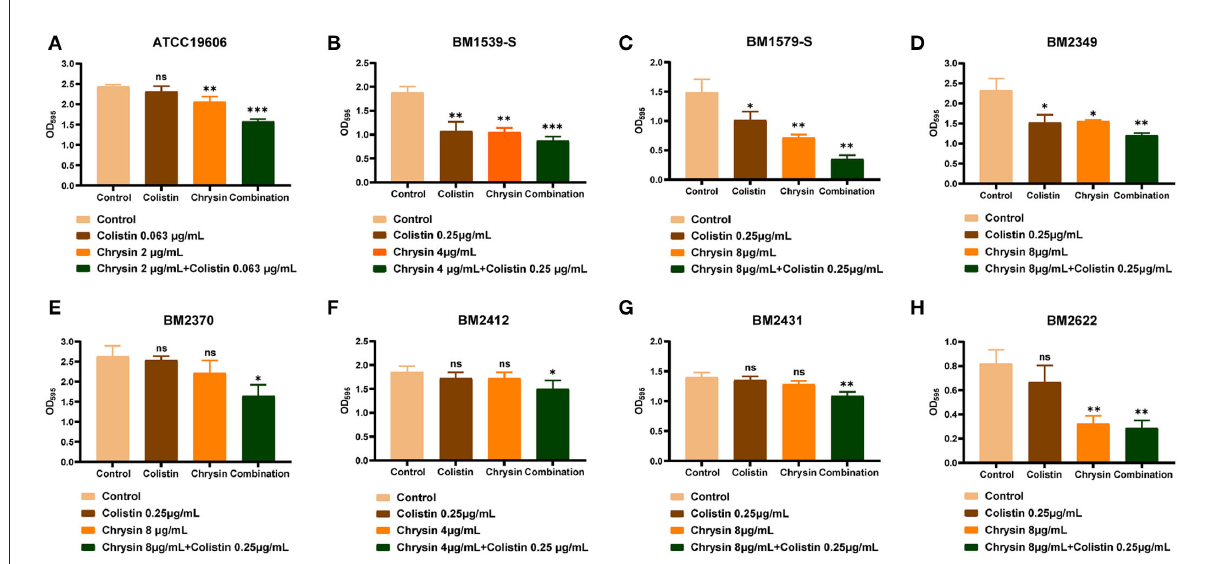
FIGURE2 Biofilm formation-inhibition effects of colistin combined with chrysin on A. baumannii . (A) ATCC 19606, (B) BM1539-S, (C) BM1579-S, (D) BM2349, (E) BM2370, (F) BM2412, (G) BM2431, and (H) BM2622. p < 0.05 (noted with*), p < 0.01 (noted with**), and p < 0.001 (noted with***). Data are expressed as the mean ± standard deviation (SD) of three replicates.